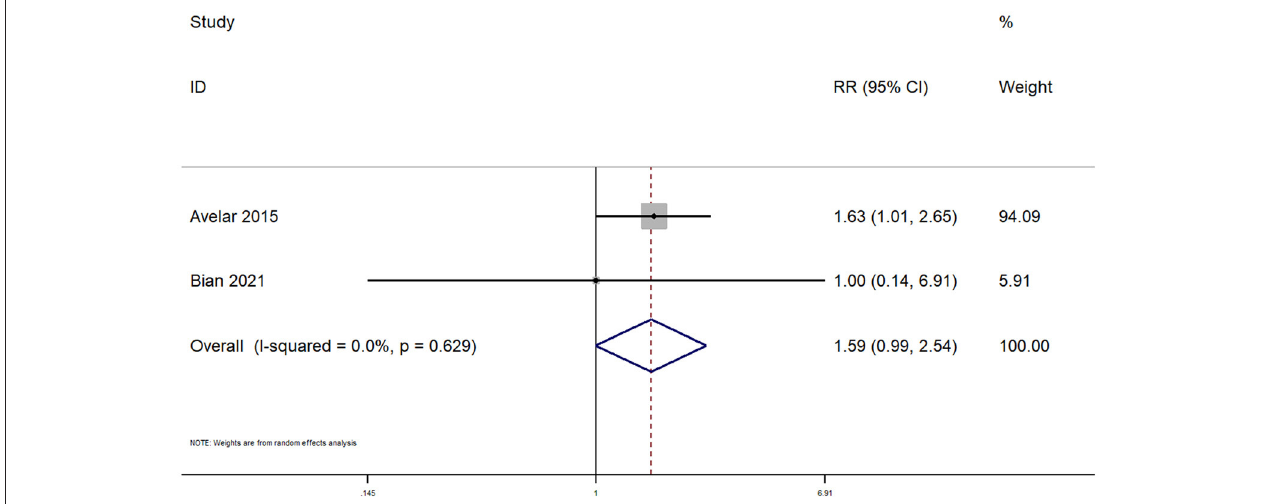
FIGURE 7 | Forest plot showing the difference in venous extravasation between ultrasound guided and conventional technique for peripheral intravenous